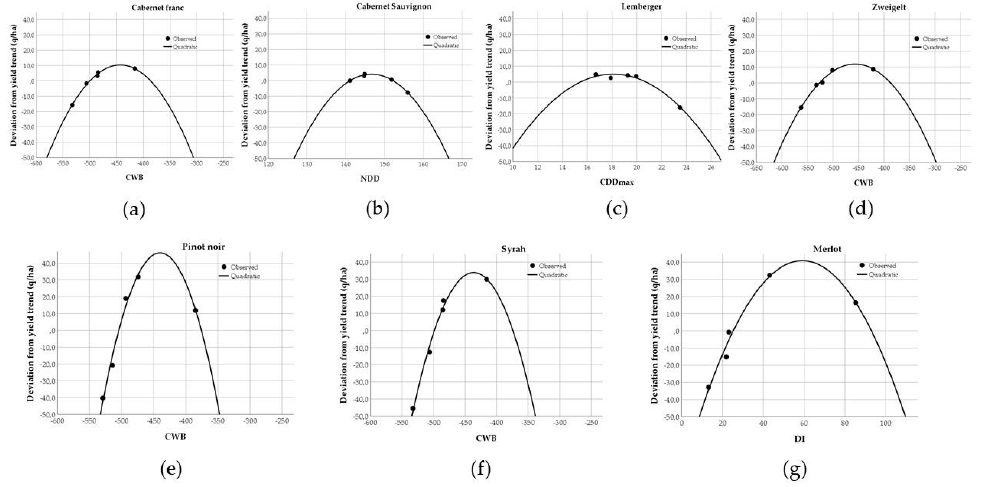
Figure 11. Functions of the best regression fit for red wine grape varieties for 2017–2021 in the Hungarian wine regions. ( a ) refers to the Cabernet franc, ( b ) refers to the Cabernet Sauvignon, ( c ) refers to the Lemberger, ( d ) refers to the Zweigelt, ( e ) refers to the Pinot noir, ( f ) refers to the Syrah, ( g ) refers to the Merlot wine grape